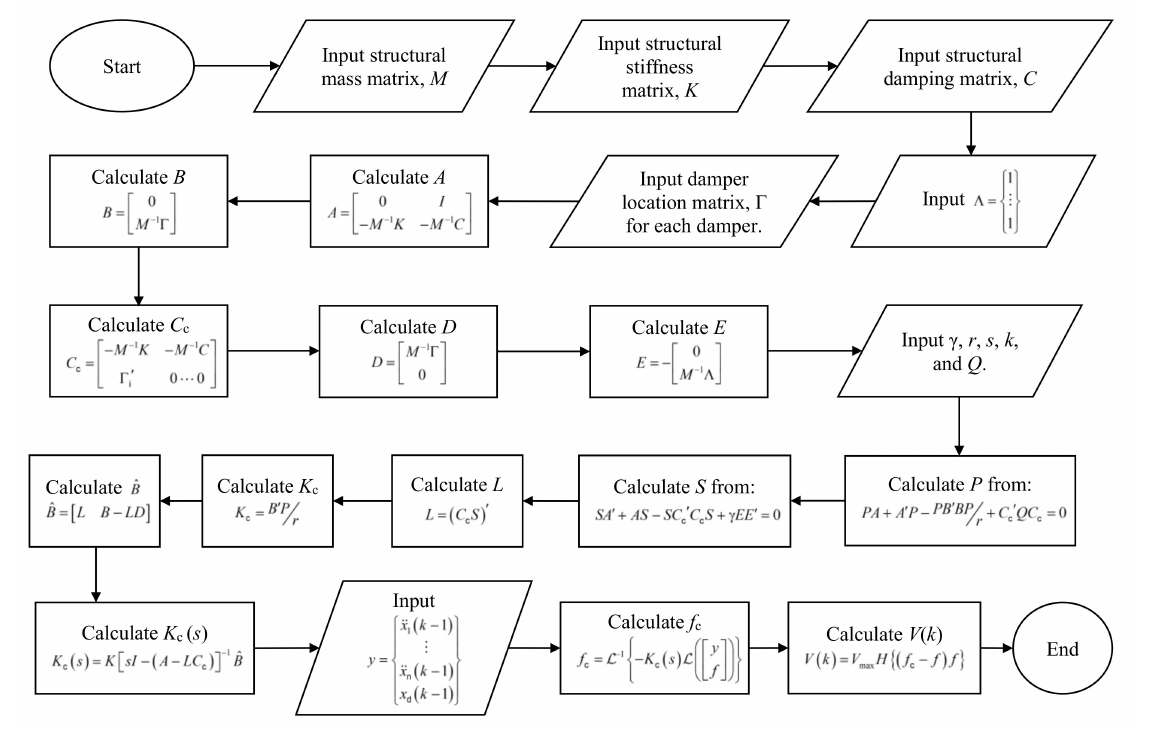
Figure 4. Flowchart for simulating clipped optimal control algorithm.